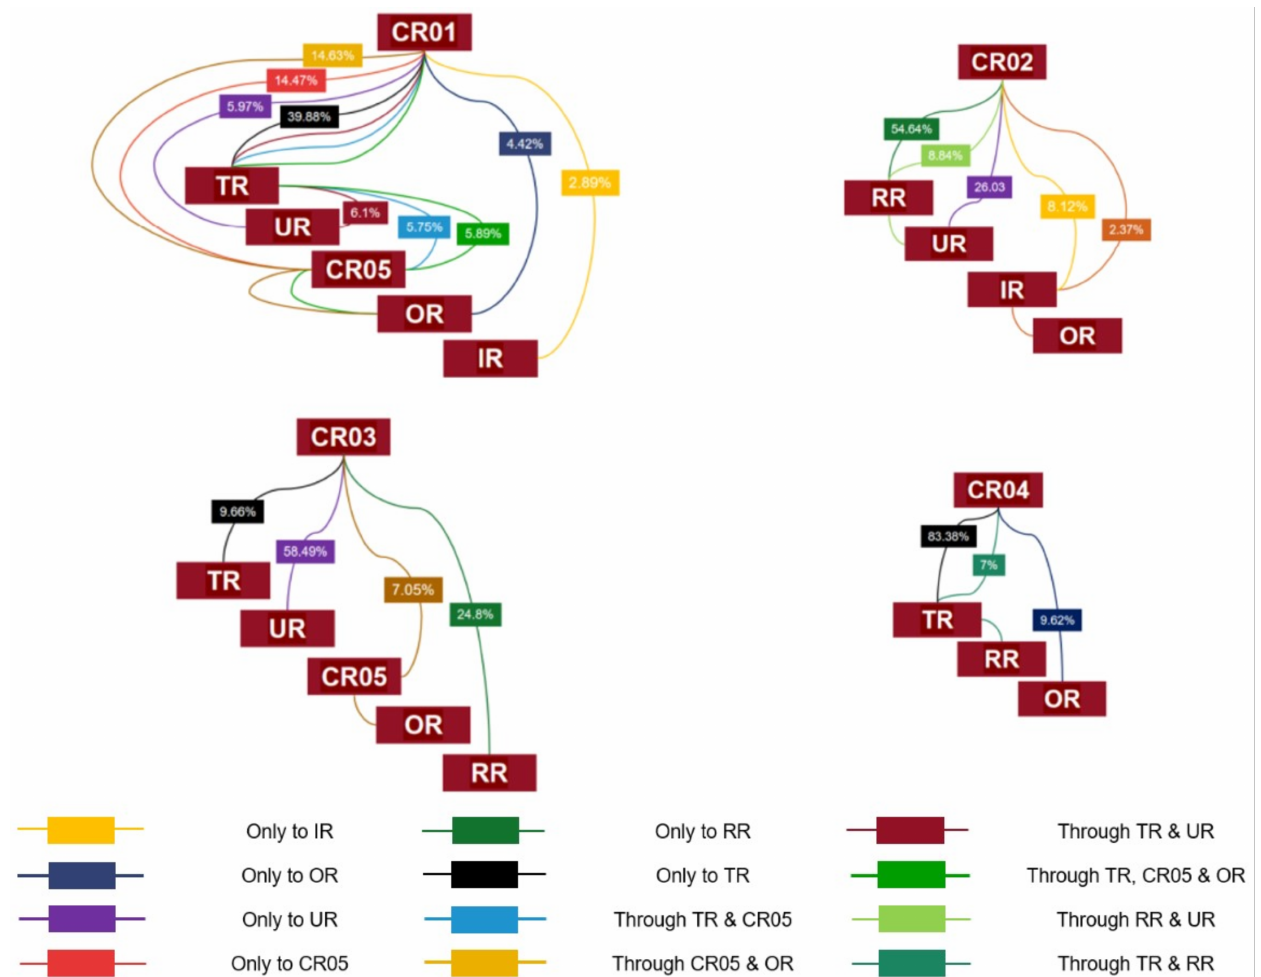
Figure 6. The third layer of